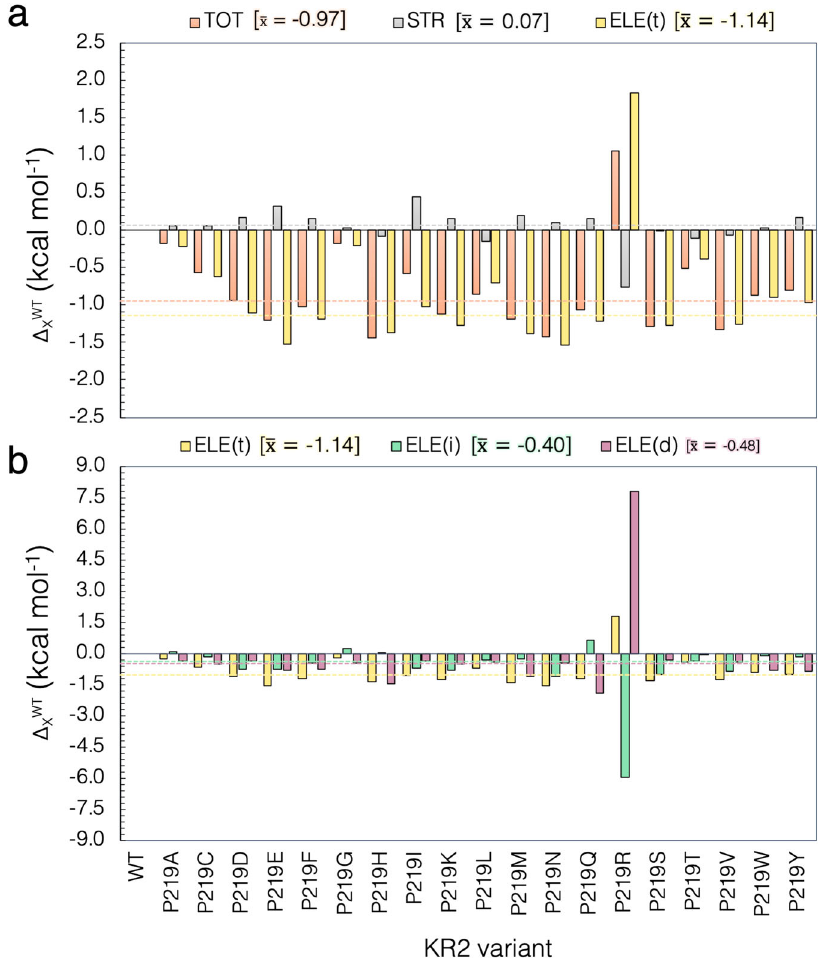
Fig. 8 Steric and electrostatic contributions to the vertical excitation energy. ( a ) Total steric (STR) and electrostatic (ELE(t)) contributions of the interaction of the retinal with the protein environment for the P219X (X = A, C, D, E, F, G, H, I, K, L, M, N, Q, R, S, T, V, W, Y). ( b ) Decomposition of the total ELE(t) electrostatic effects on its indirect (ELE(i)) and direct (ELE(d)) components. Row data is provided in Supplementary Table 5. The dashed lines and corresponding numerical values refer to the weighted average values ð (cid:1) x Þ of the 18 residues of the red-shifted cluster exclusively, presented in square